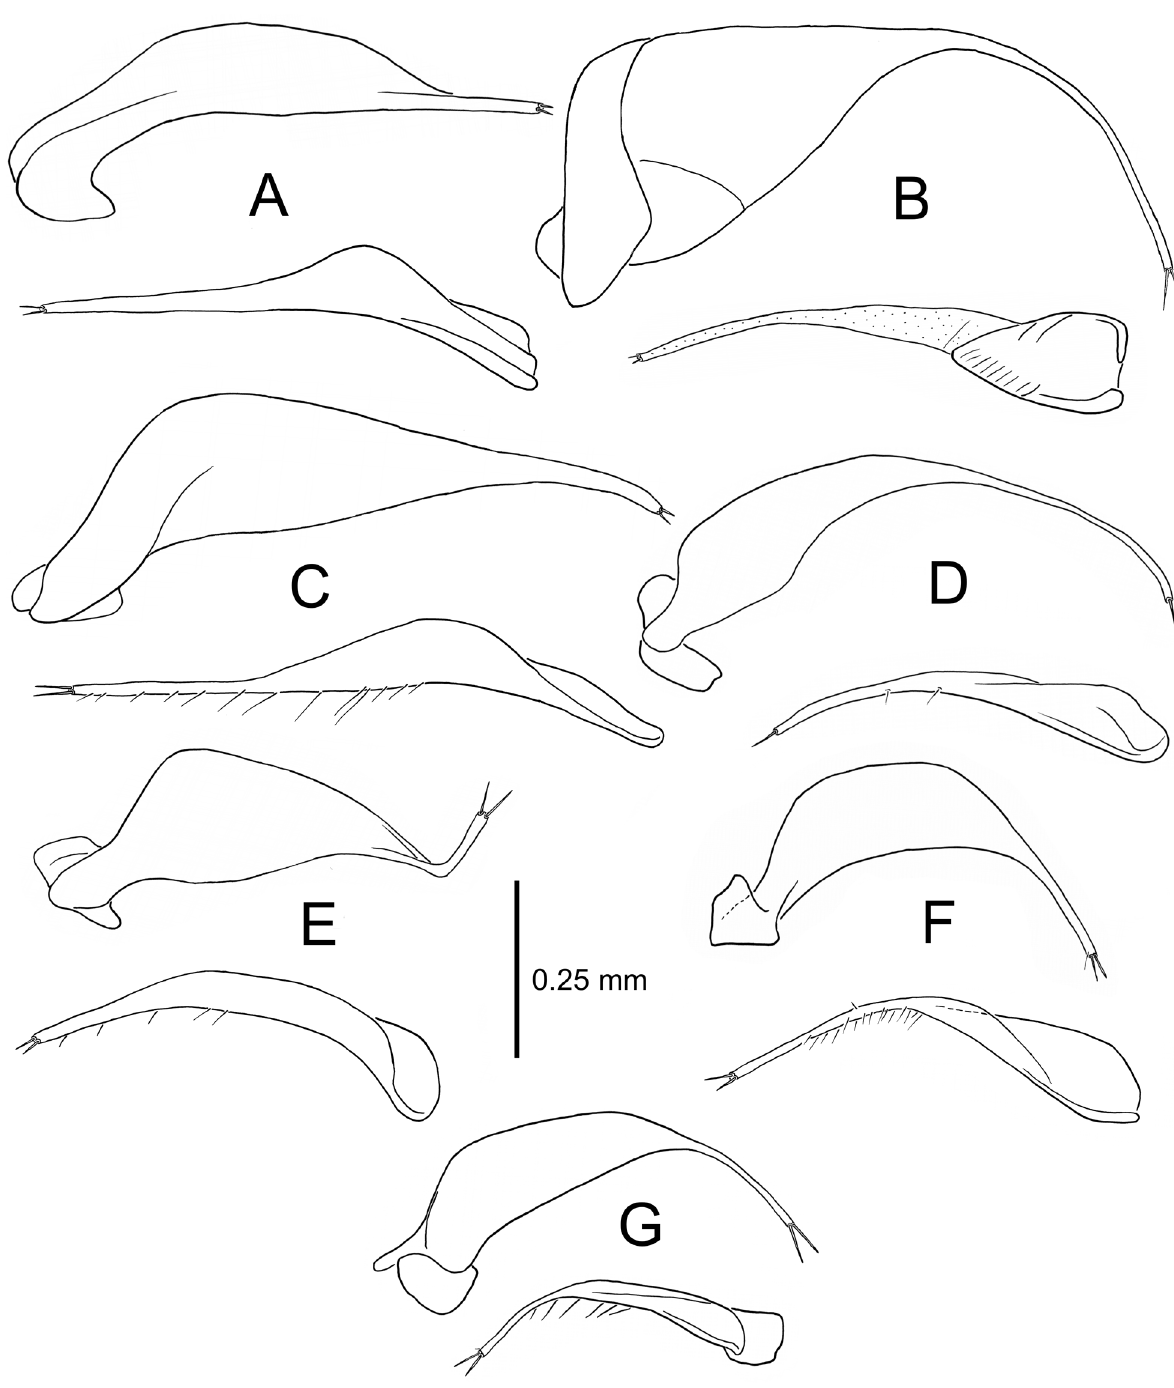
Figure 18. Paired left (above) and right (below) parameres of Mecyclothorax ( Phacothorax ) spp. (ectal view): A , M. plurisetosus ; B , M. megalovatulus ; C , M. octavius ; D , M. laterovatulus ; E , M. manautei ; F , M. paniensis ; G , M. mouensis .